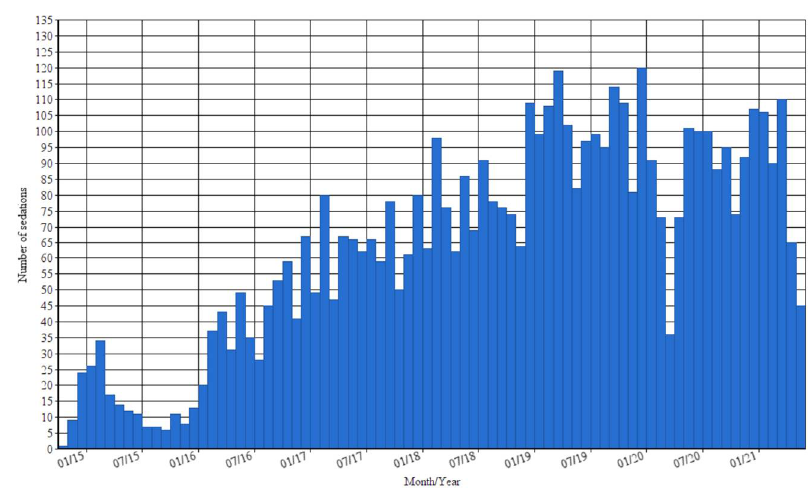
Figure 2 is a representation of the number of sedations per month.